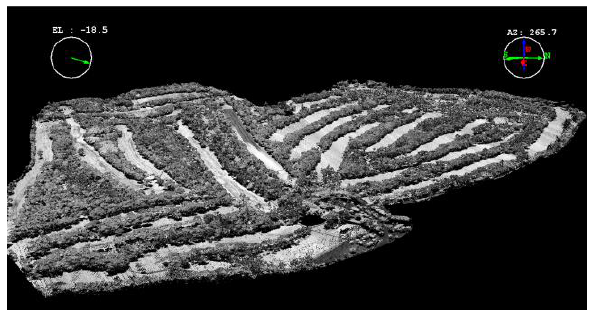
Figure 1. The point cloud covering the study area